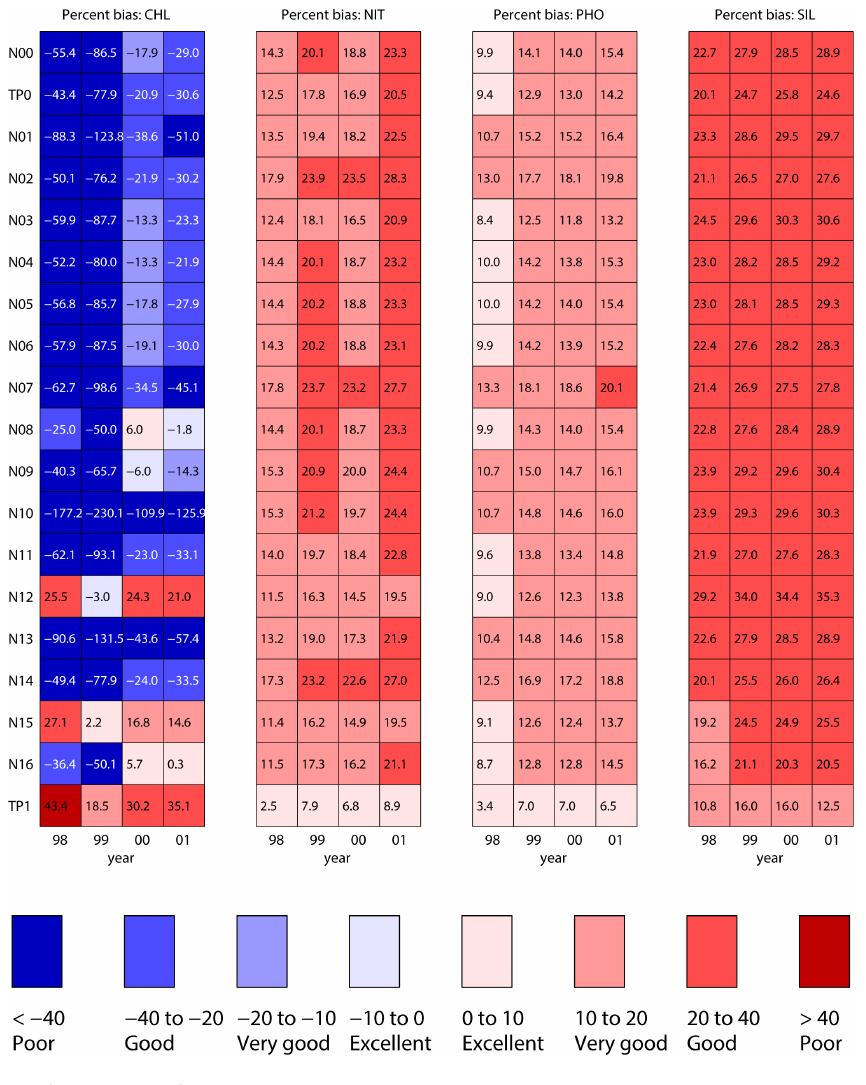
Figure 6. Percentage bias (Pbias, see text) for the model simulations compared to all available observations from the period